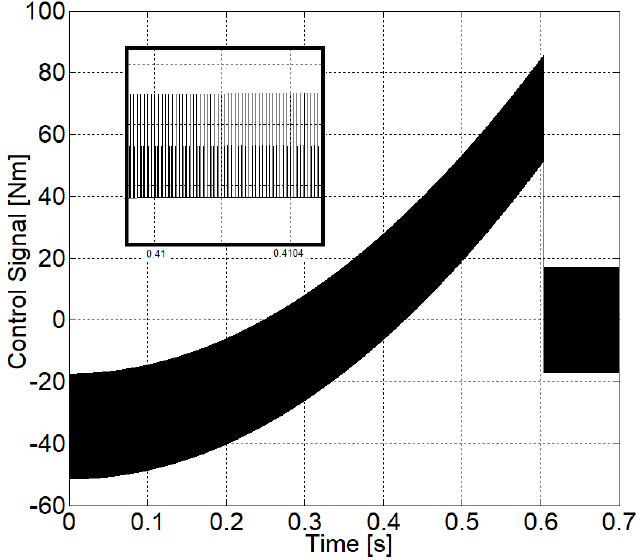
Figure 6. Control signal with the velocity